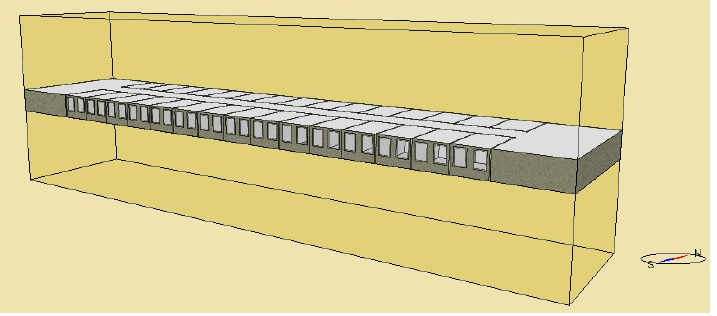
Figure 4. Schematic view of the reference model for an office building.